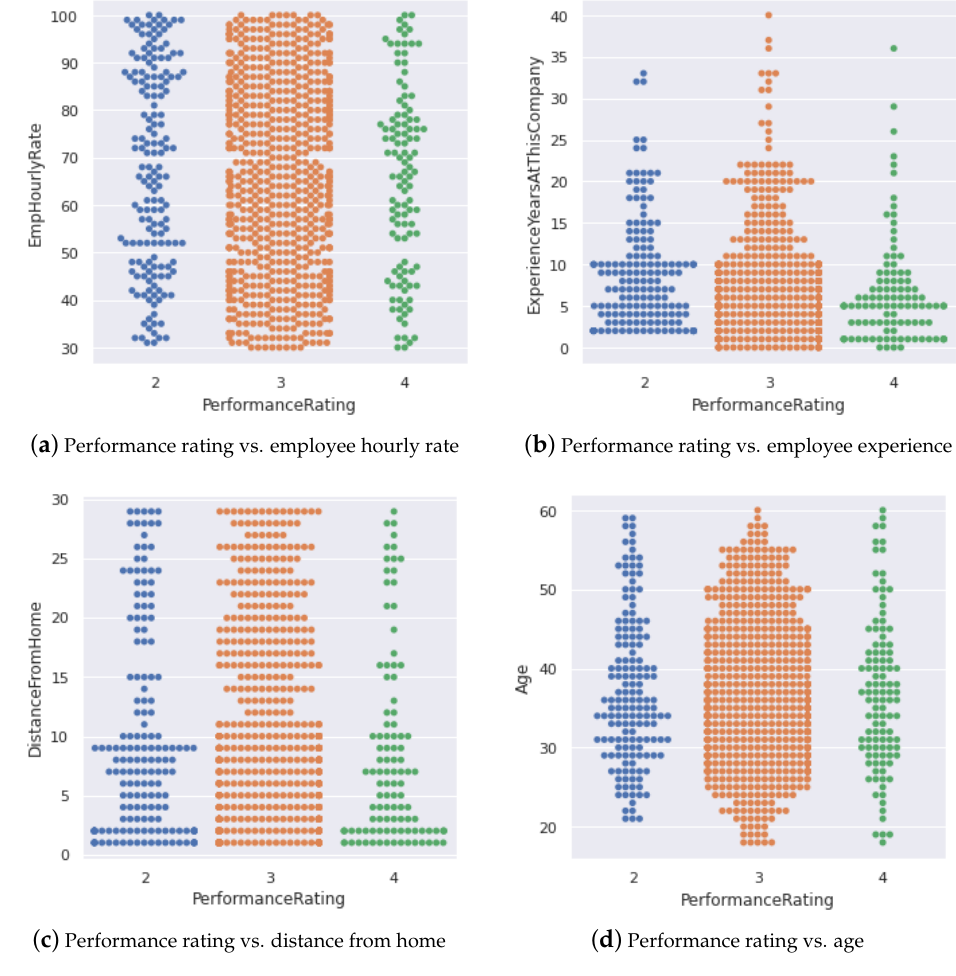
Figure 2. Comparison of performance rating with different columns of the